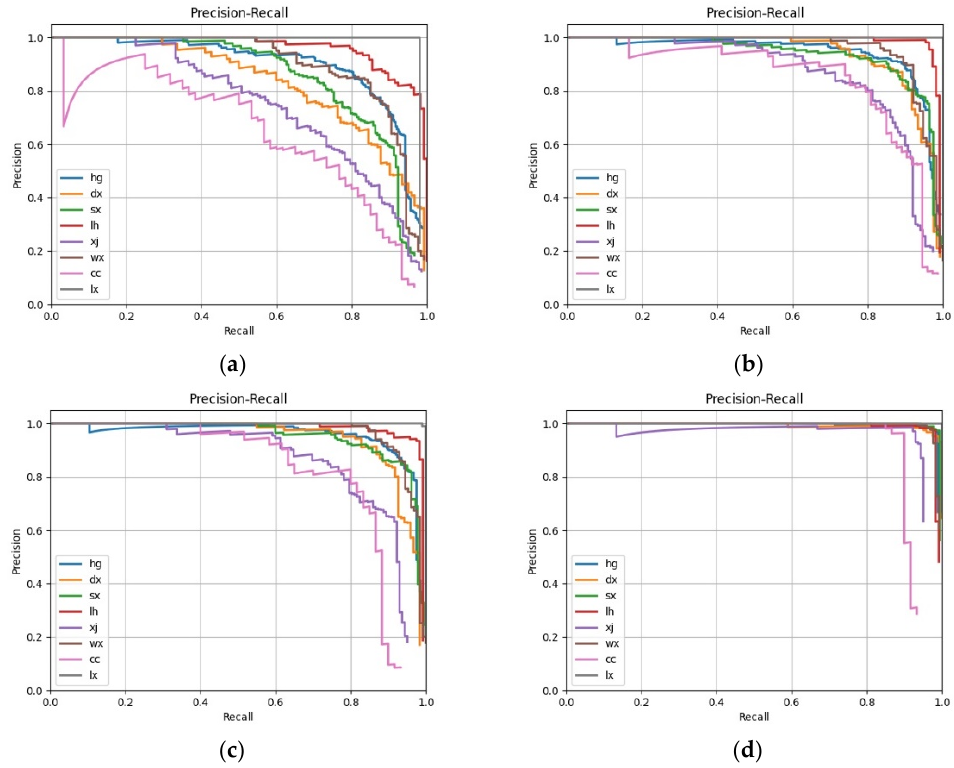
Figure 6. P-R curves of different methods in ablation experiment: ( a ) FPN; ( b ) FPN with CAFUS; ( c ) FPN with FEM; ( d ) multi-scale feature network. Table 2. APs and mAPs of different methods in the ablation experiment.